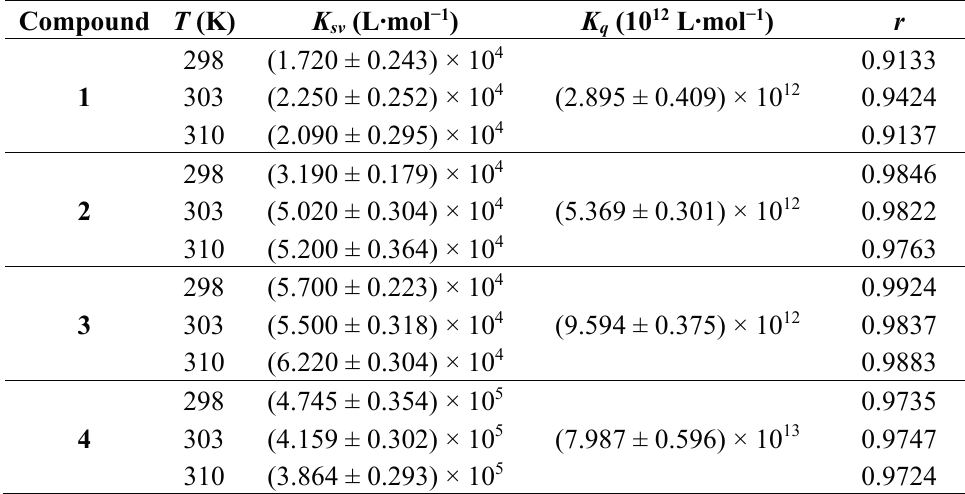
Figure 7. Stern-Volmer linear plot of fluorescence quenching of BSA by compounds 1 – 4 at different temperatures. Table 1. Quenching constant of the interaction between compounds 1 – 4 and BSA at different